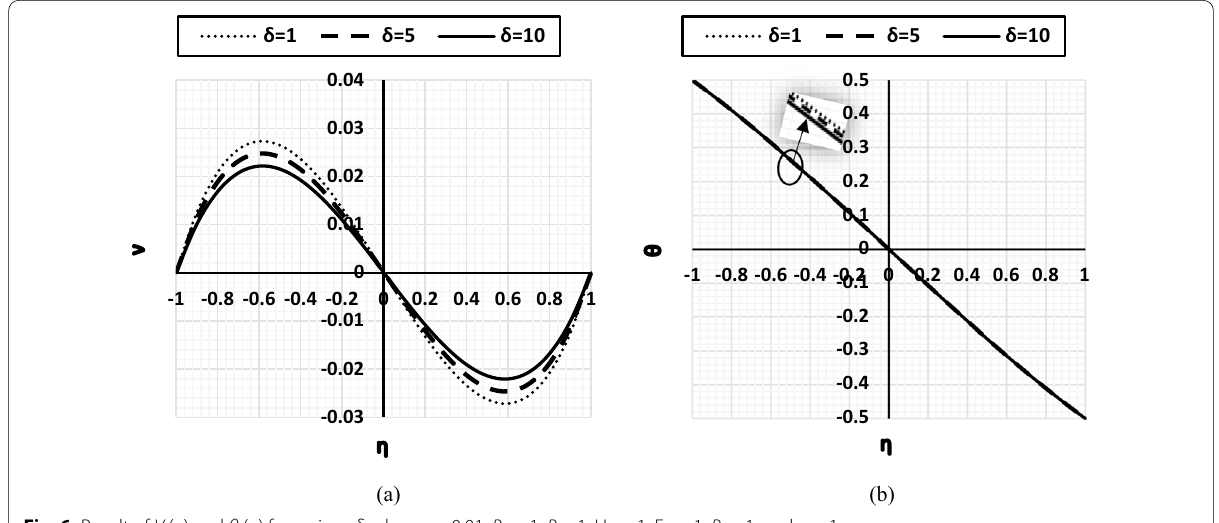
Fig. 6 Result of V ( η ) and θ ( η ) for various δ when ϕ